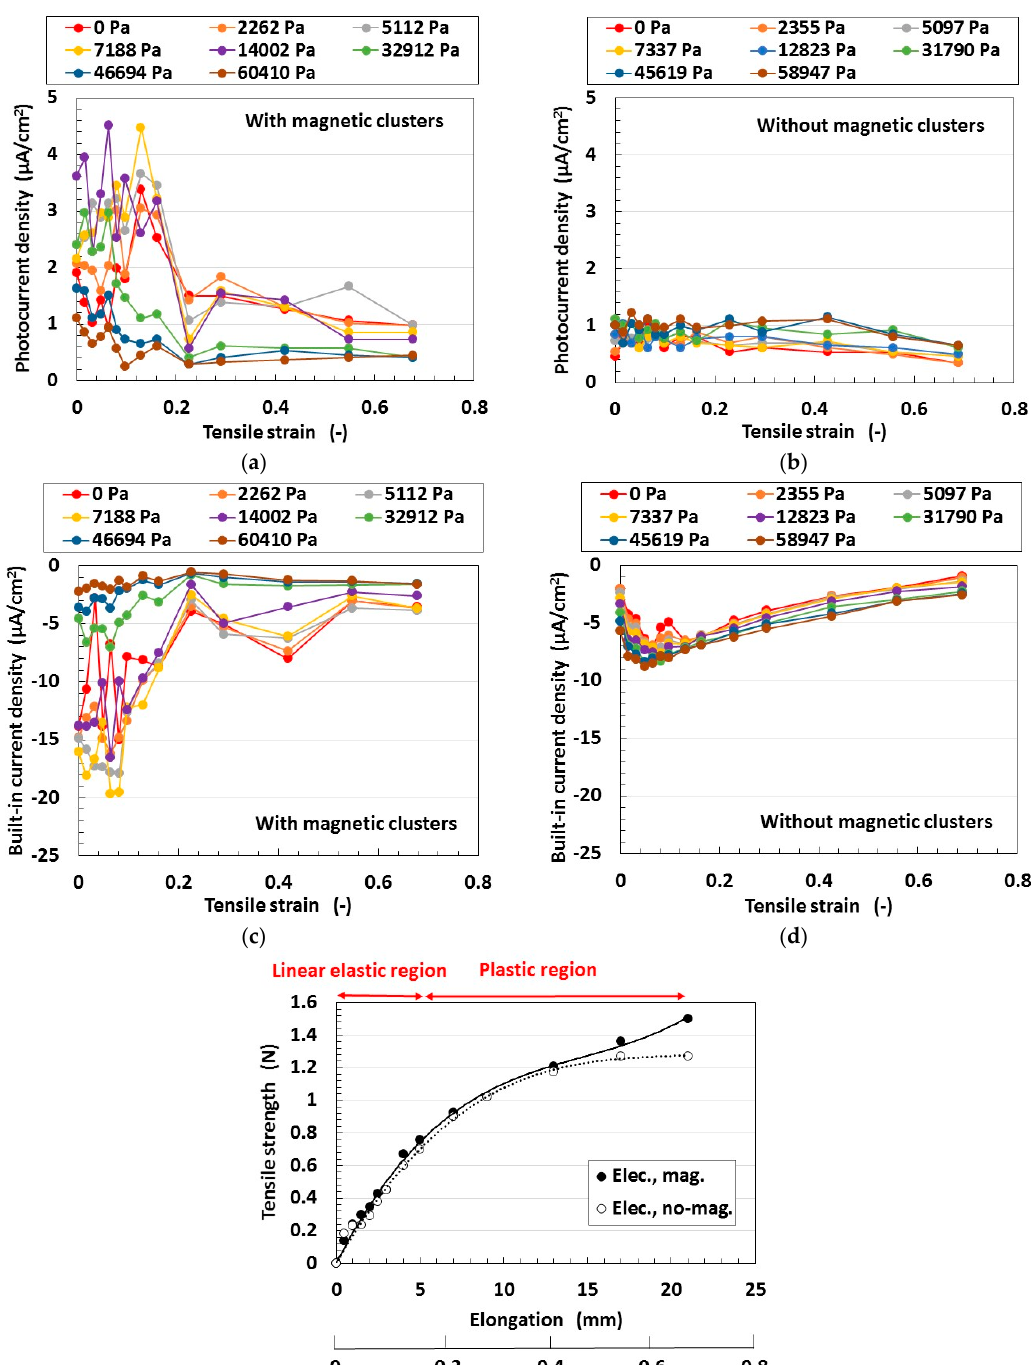
Figure 12. Changes in the effect of magnetic clusters by tension under irradiation with ultraviolet light: ( e ) shows the relation between the tensile strength and the elongation for the various cases from ( a – d ) for wet-type MCF rubber solar cell electrolytically polymerized under a magnetic field with Ruthenium complexes dye and electrolyte KI + I 2 .